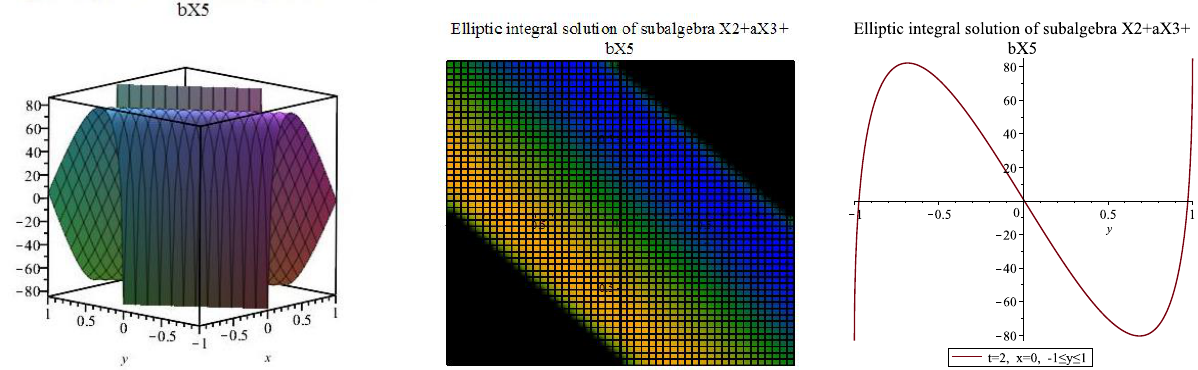
Figure 18. Solitary wave depiction of elliptic integral solution (68) at t = 2.